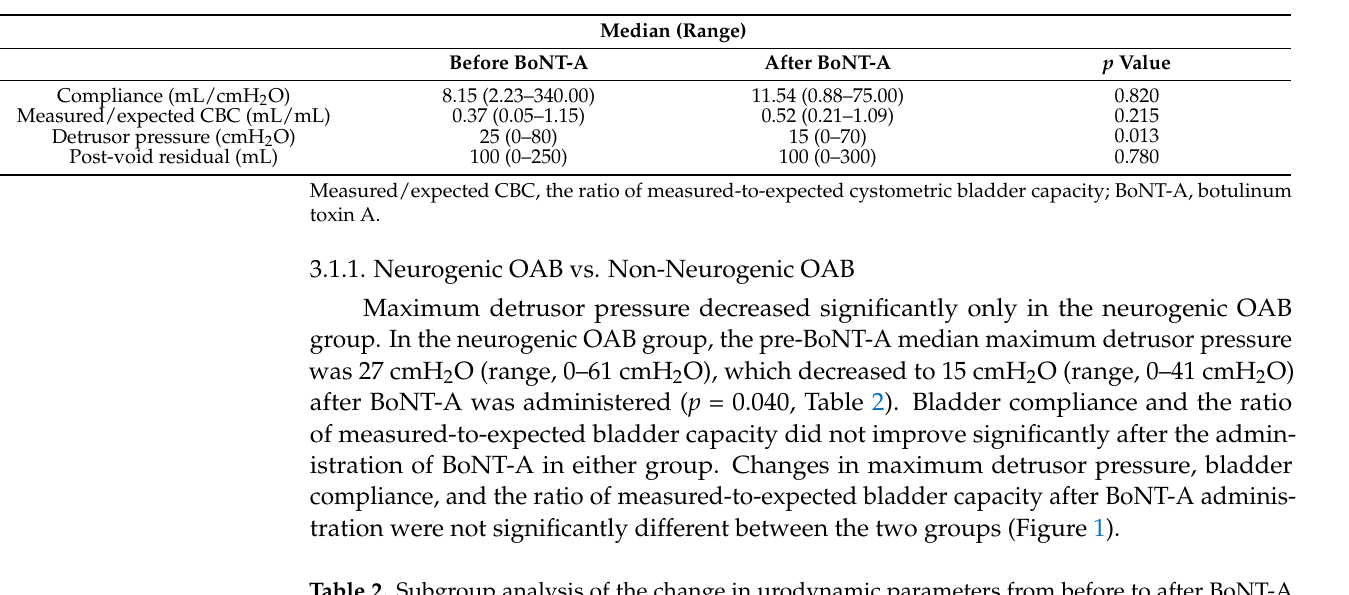
Table 2. Subgroup analysis of the change in urodynamic parameters from before to after BoNT-A